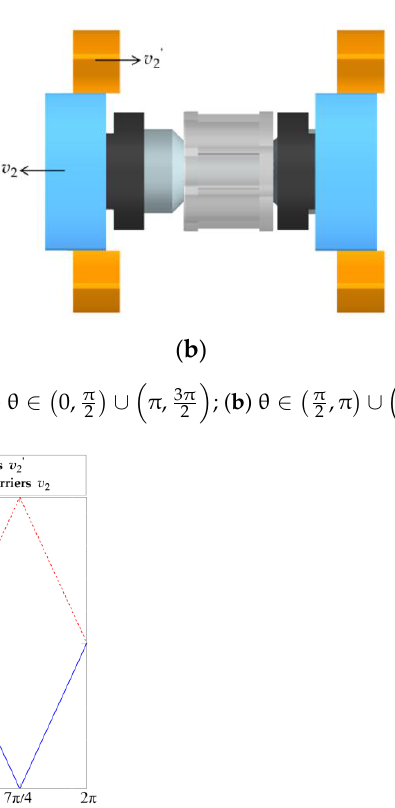
Figure 4. The axial velocity of the carriers.